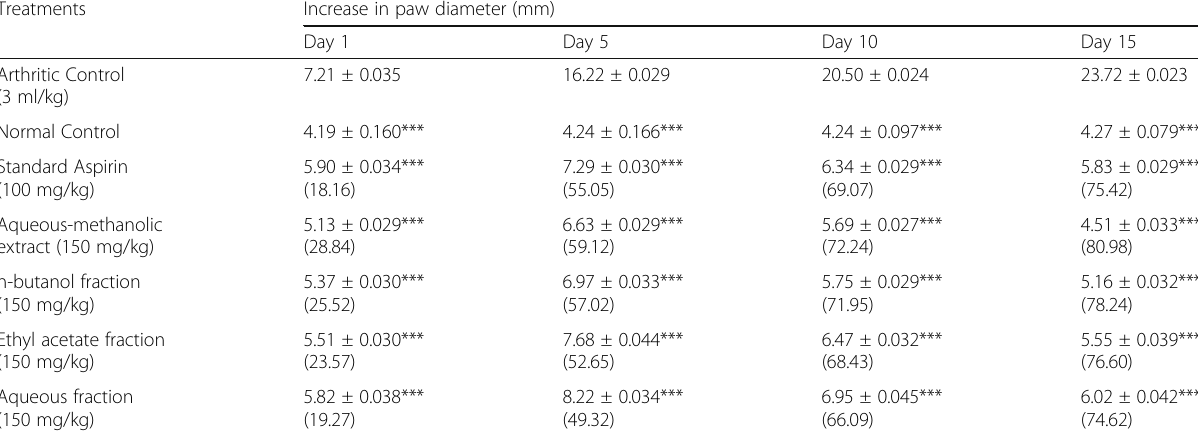
Table 3 Effect of B.orthobotrys on CFA induced arthritis in rats ( n = 5, Mean ± SEM)